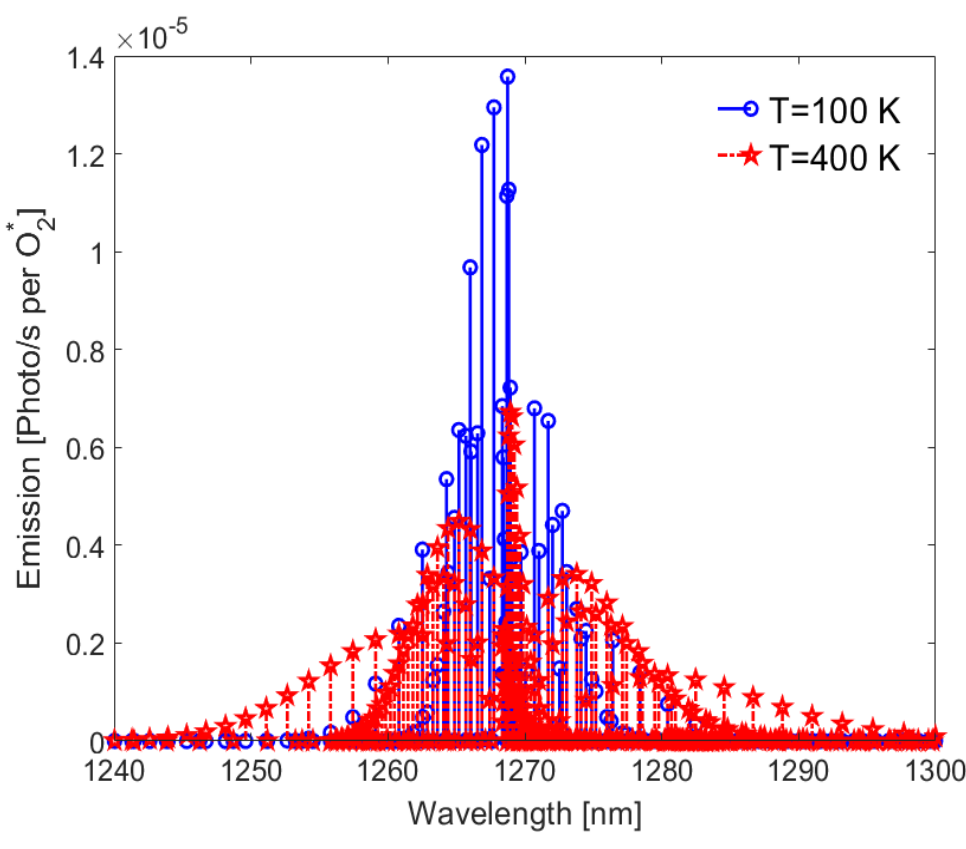
Figure 4. The emission spectrum of the O 2 (a 1 Δ g ) band as a function of the transition